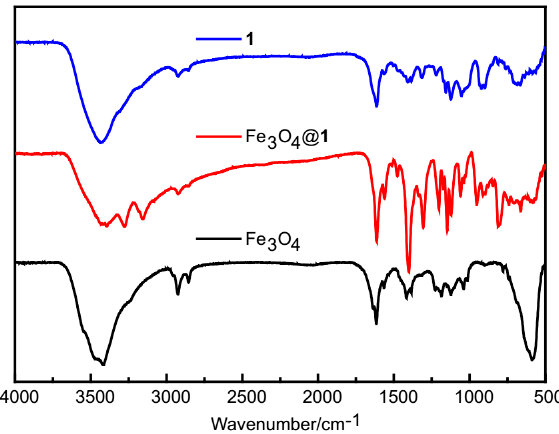
Figure 2. The FTIR spectra of 1 , Fe 3 O 4 @ 1 and Fe 3 O 4 .